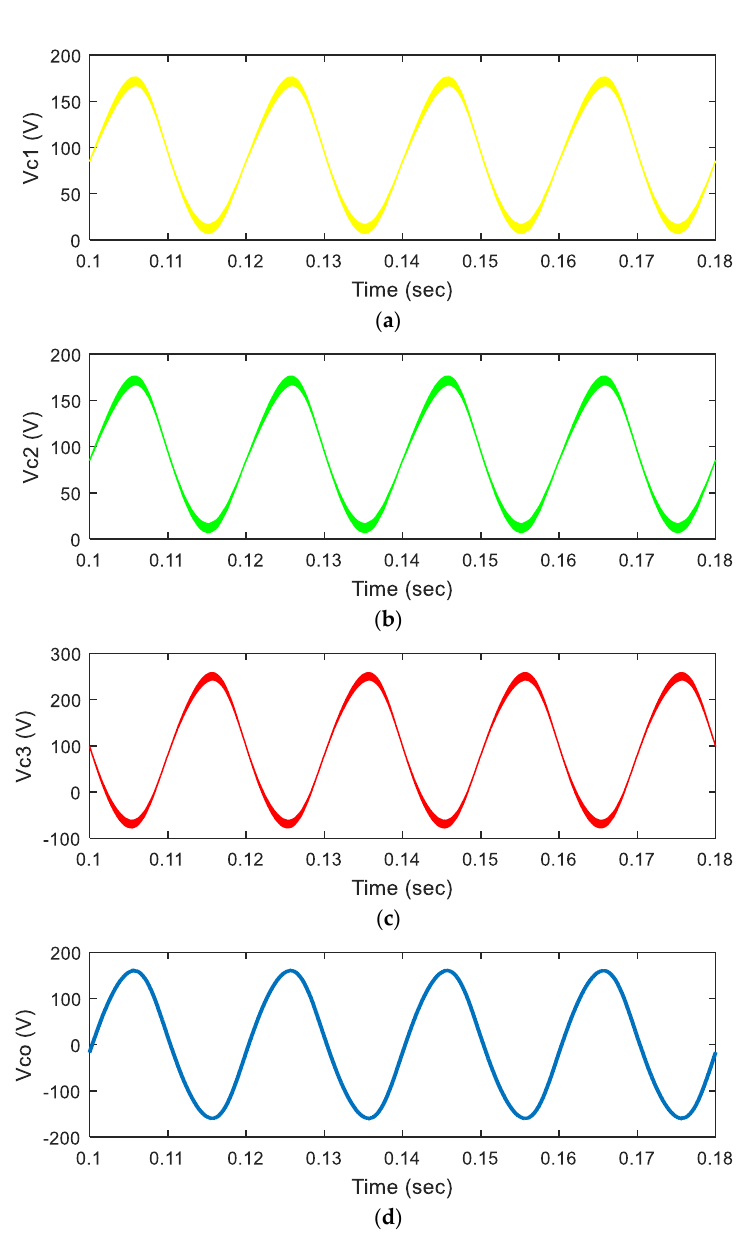
Figure 7. Input voltage at 90 V and load at 10 Ω for CUK -based ZSI. Voltage wave of ( a ) capacitor C1;